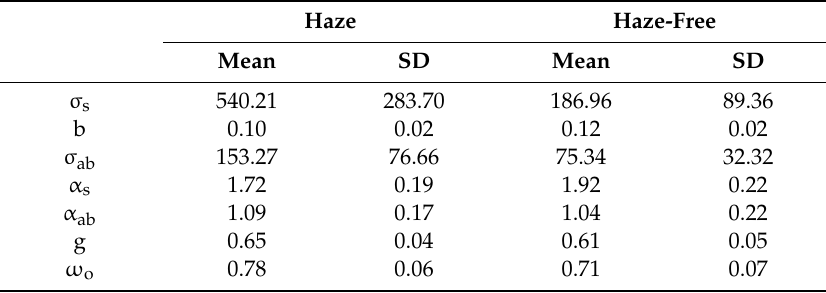
Table 4. Statistics of each aerosol optical parameter on haze and haze-free days.